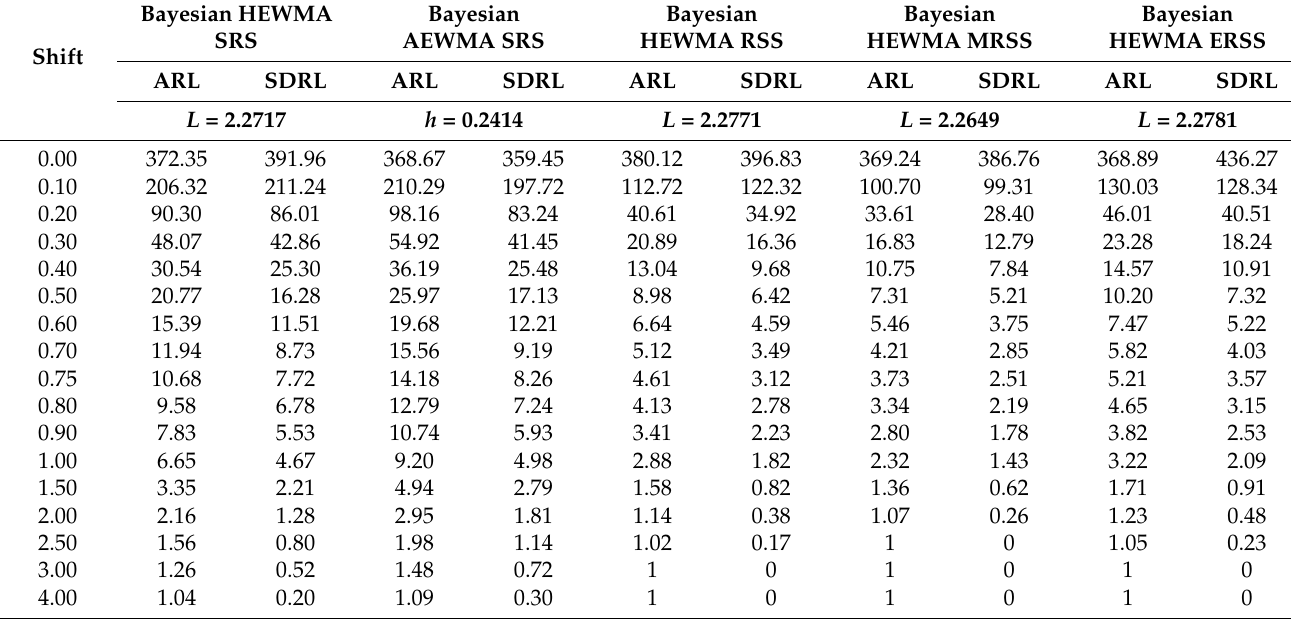
Table 6. The ARL and SDRL values of Bayesian HEWMA and Bayesian AEWMA control chart